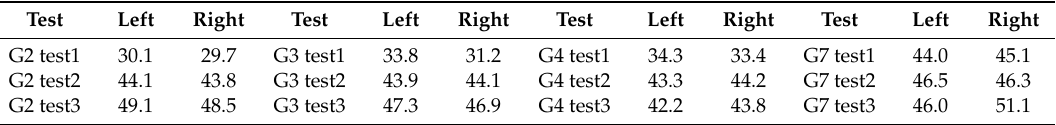
Table 4. Comparison of the flicker fusion frequency in three assessments in all